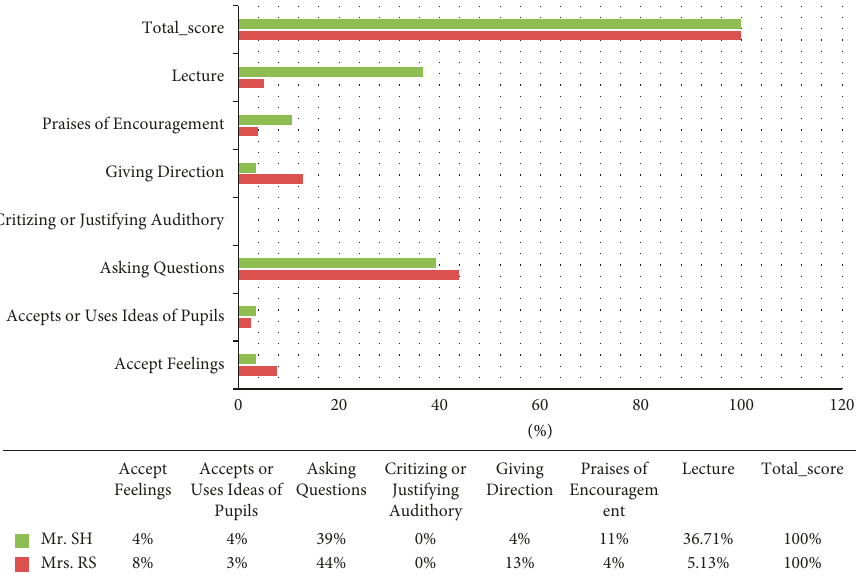
Figure 1: The frequency of teacher talk.